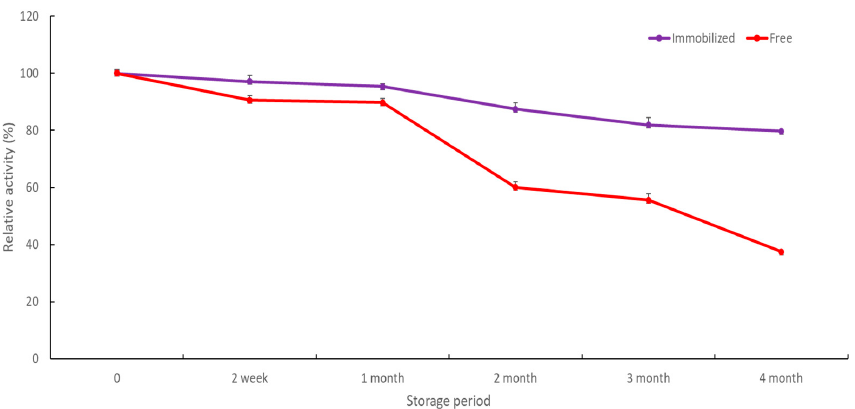
Figure 10. Effect of immobilized YT PTE storage stability. Storage stability at 4 °C; Purple line: Immobilized YT PTE. Red line: Free enzyme.